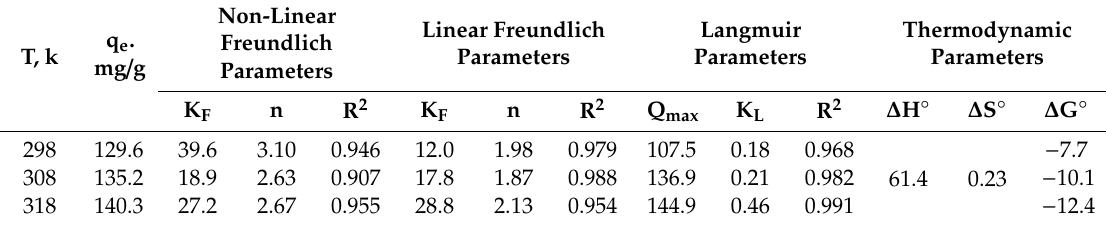
Table 3. Freundlich, Langmuir parameters for the adsorption of the uranyl ions into the fabricated NaZrP-CEX ion-exchanger at di ff erent